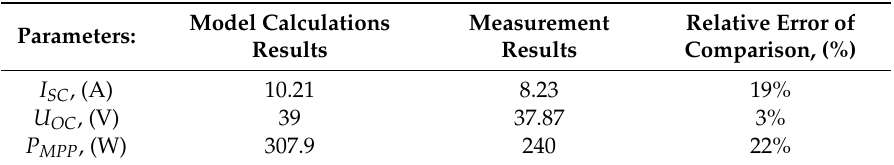
Table 4. Comparison of results of calculations of parameters according to models (5), (6), and (7) with the results of measurements for a 35.5 ◦ C PV module temperature. Model Parameters: